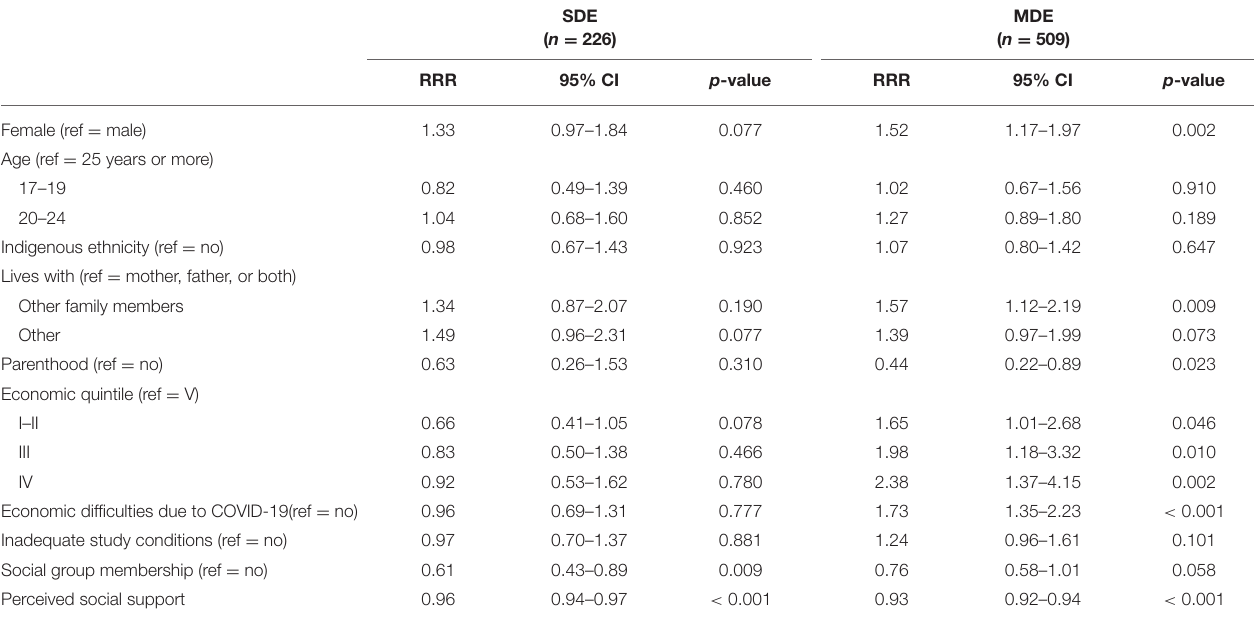
TABLE 2 | Social and economic factors associated with SDE and